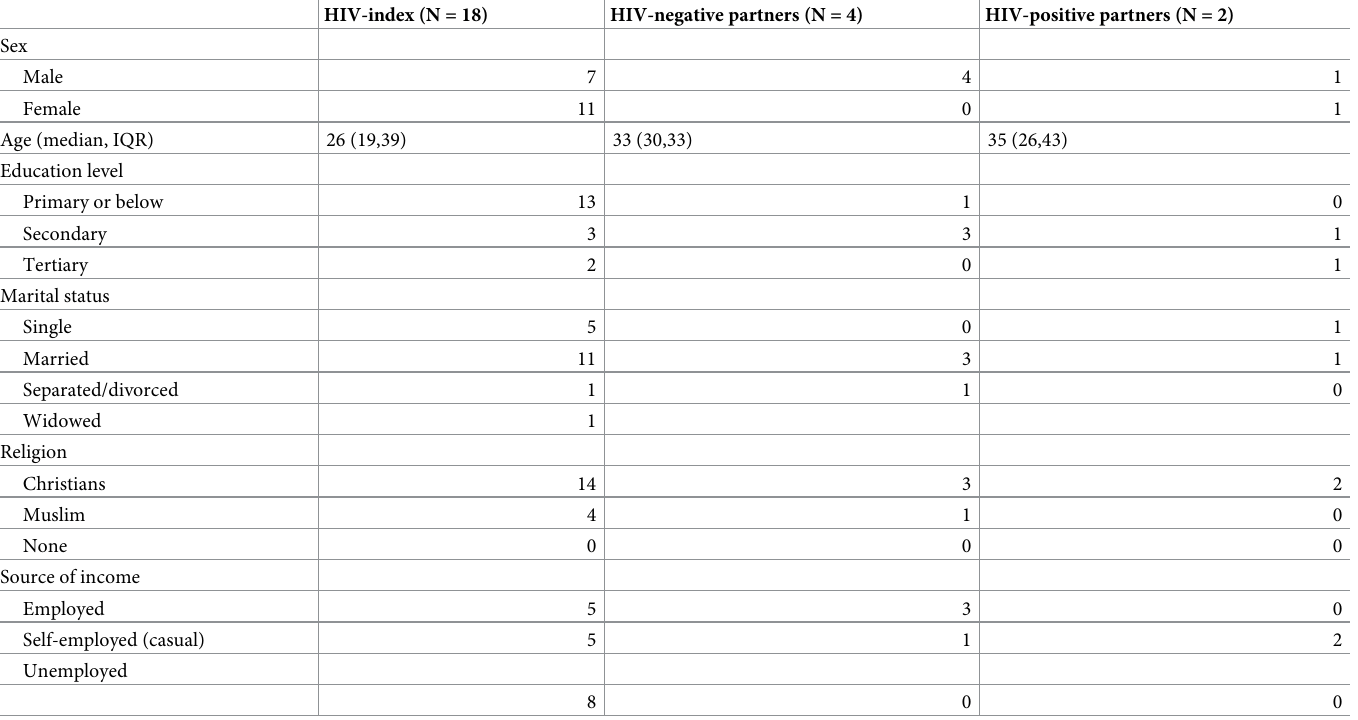
Table 1. Socio-demographic characteristics of index HIV-participants; HIV-negative and positive partners, Tambua Mapema Plus trial, coastal Kenya,